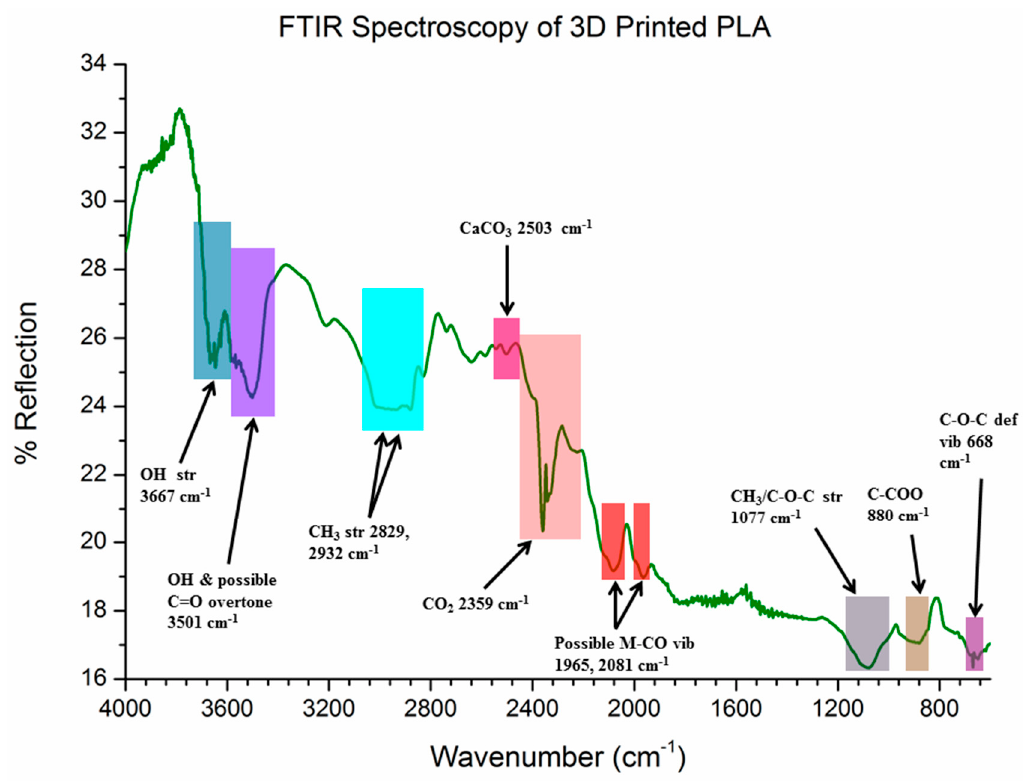
Figure 7. Diffuse Reflectance FTIR (DRIFTS) spectroscopy of 3D ‐ printed PLA.